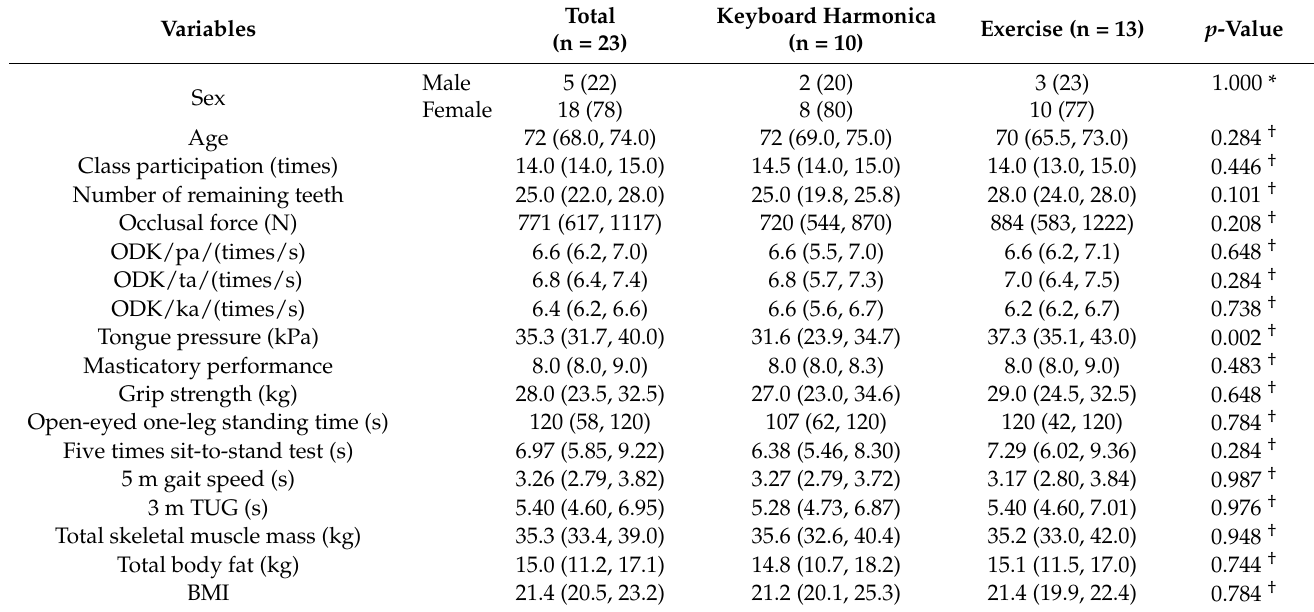
Table 1. Comparison of variables between the keyboard harmonica and exercise groups at baseline.